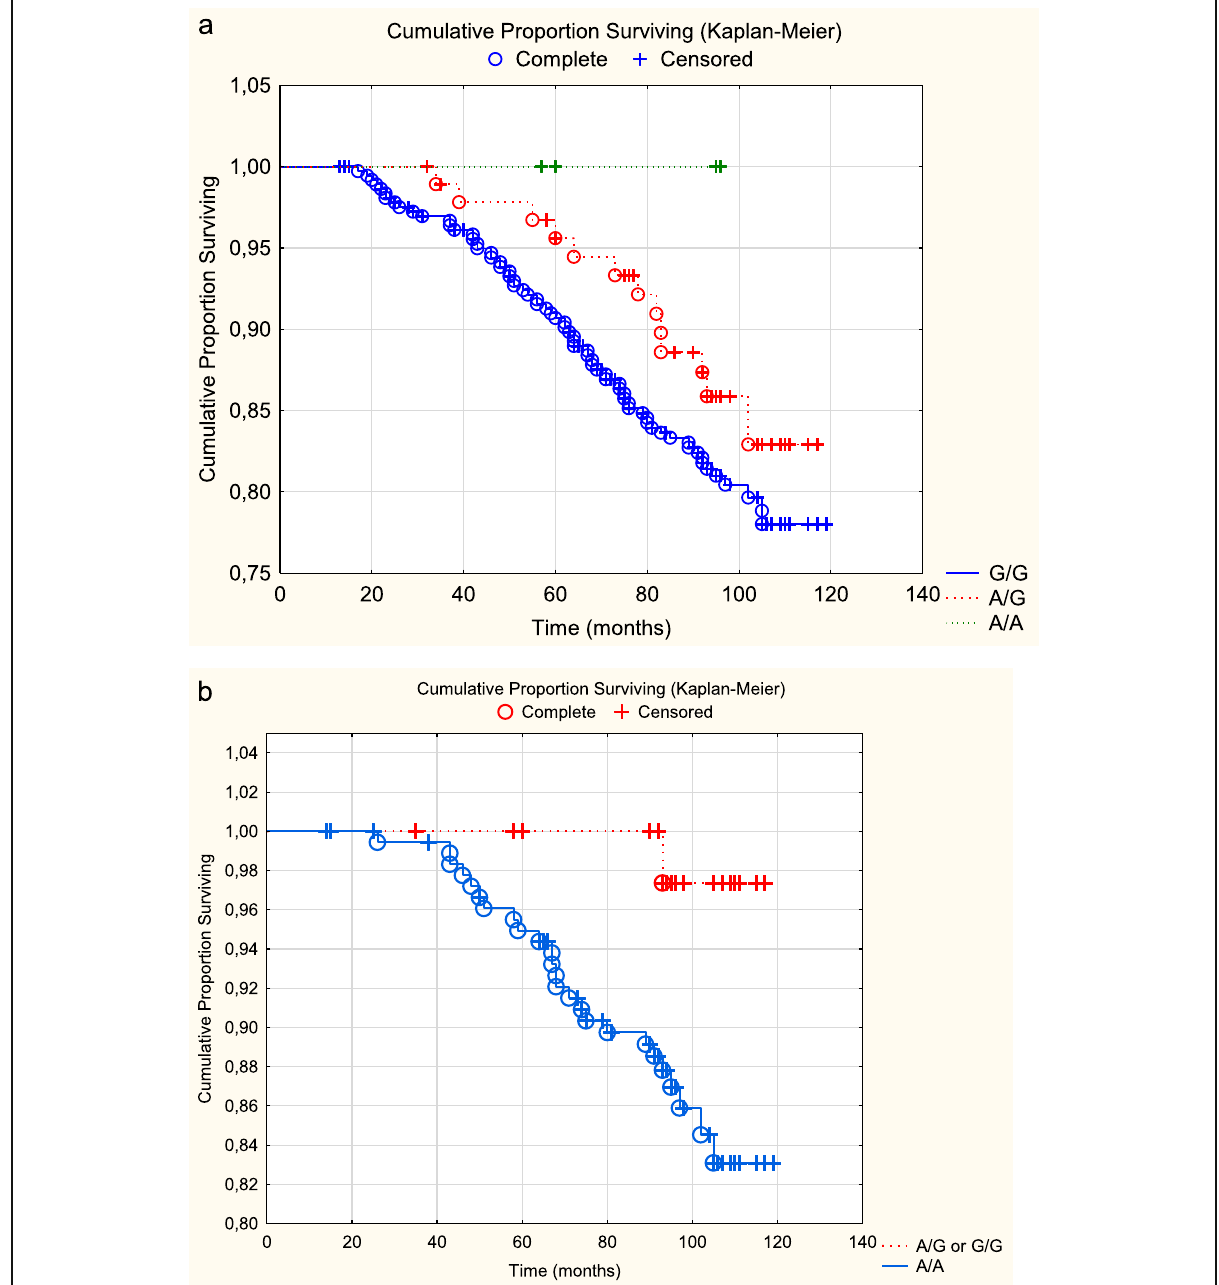
Fig. 2 a Cardiovascular mortality of the three genotypes of rs2228262 in the total study population during a follow-up time of 7.9 years. Note: Censored participants were those still living at the end of the study period, or who had died for reasons other than cardiovascular disease. Completed participants were those who had died due to cardiovascular disease. b . Cardiovascular mortality of the three genotypes of rs2228262 in the female population during a follow-up time of 7.9 years. Note: Censored participants were those still living at the end of the study period, or who had died for reasons other than cardiovascular disease. Completed participants were those who had died due to cardiovascular